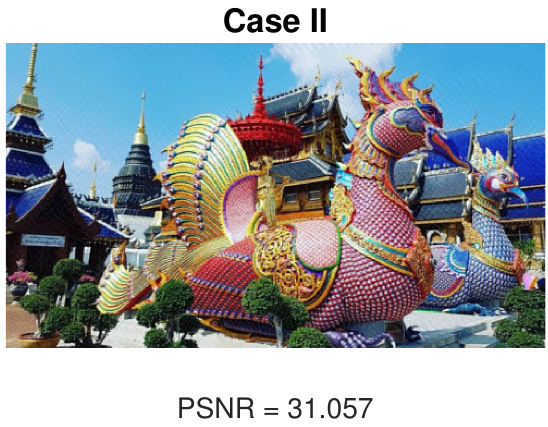
Figure 25. The reconstructed RGB image with their PSNRs for three different cases using the proposed algorithm presented in 10,000 iterations, respectively.